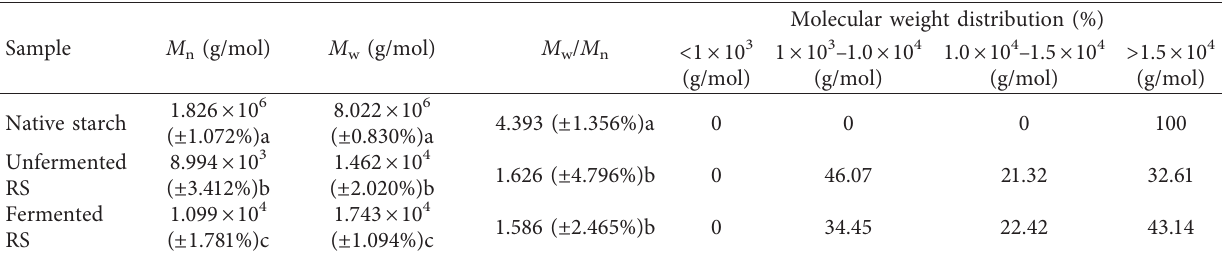
Table 3: Determination of molecular weight of sorghum starch and resistant starch. Sample